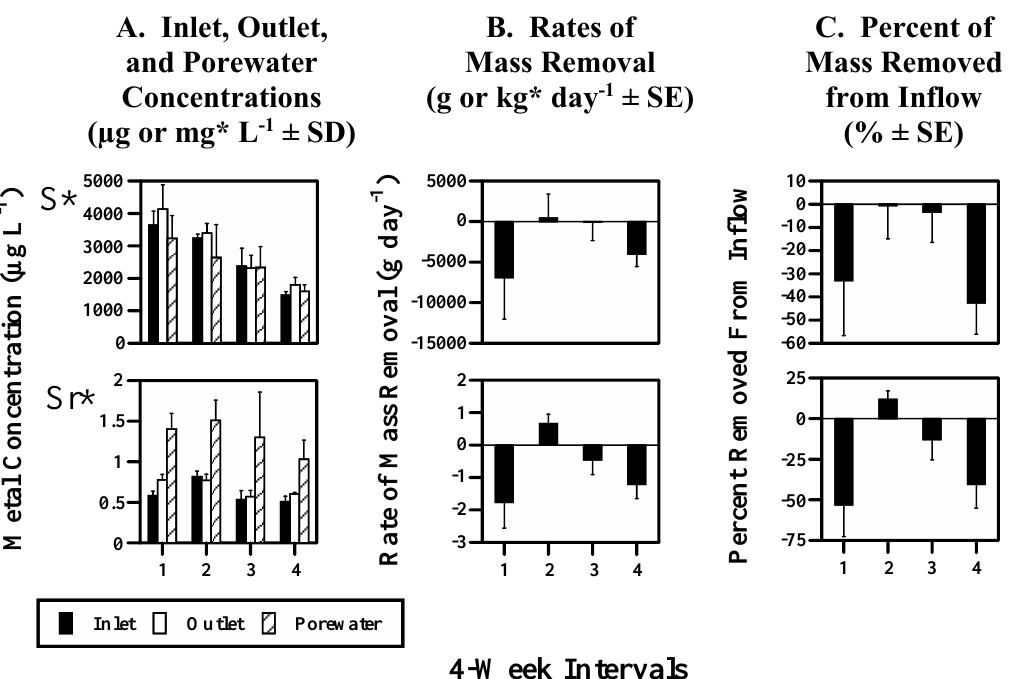
Figure 3. Source elements: S and Sr. Periodic (4-week) mean values for: ( A ) Inlet, Outlet, and Porewater concentrations ( µ g or mg * L − 1 ± standard deviation; n = 4 for Inlet and Outlet; n = 15–30 for Porewater); ( B ) Rates of mass removal (g or kg * day − 1 ± standard error); and ( C ) Percent of mass removed from inflow ( ± standard error) during the 16-week study period.